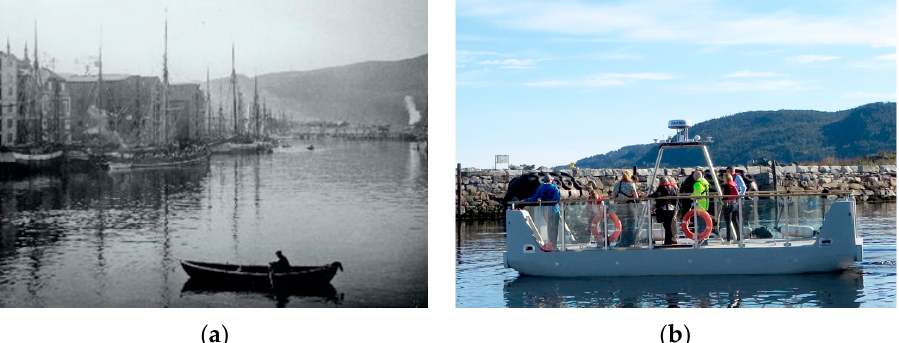
Figure 3. The service of crossing an urban canal in Trondheim, Norway is undergoing a digital transformation in the Autoferry project [34] ( a ) The Fløttman in 1906 (photo credit A. Holbæk Eriksens Publishers and The Municipal Archives of Trondheim; licensed under a Creative Commons Attribution 2.0 Generic License); ( b ) The autonomous milliAmpere2 in October 2021 (photo Erik A. Veitch).